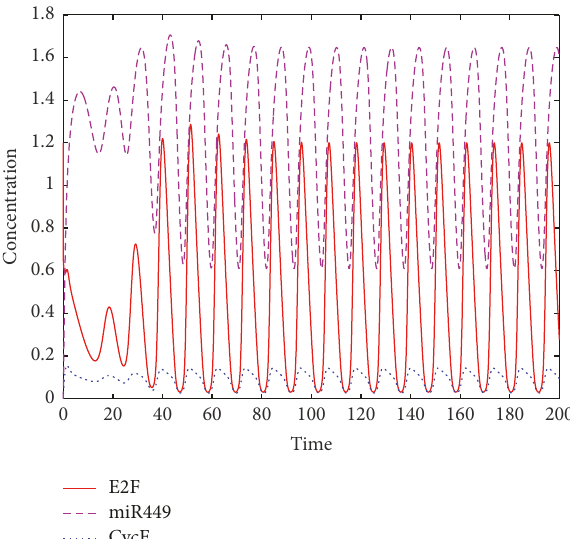
Figure 4: A periodic solution bifurcated from equilibrium for 𝜏 = 𝜏 1 = 𝜏 2 = 𝜏 3 > 𝜏 0 . Assume initial conditions are 𝑥 1 = 1.2, 𝑥 2 = 0, 𝑥 3 = 0, 𝑥 = 0, 𝑥 = 0, 𝑥 = 0.55, 𝑥 = 0, 𝑥 = 0 , and 𝑆 = 5, 𝑘 4 5 6 7 8